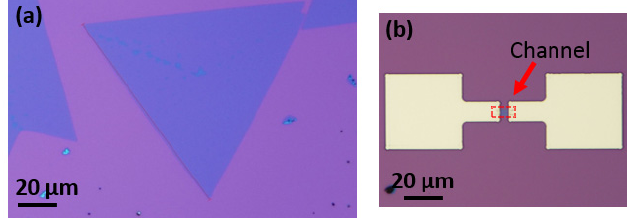
Figure 1. ( a ) Optical microscope (Olympus, Tokyo, Japan) image of chemical vapor deposited (CVD) MoS 2 crystals; ( b ) An image of the MoS 2 field effect transistors (FET) with channel dimensions of 3 μ m × 9 μ m.